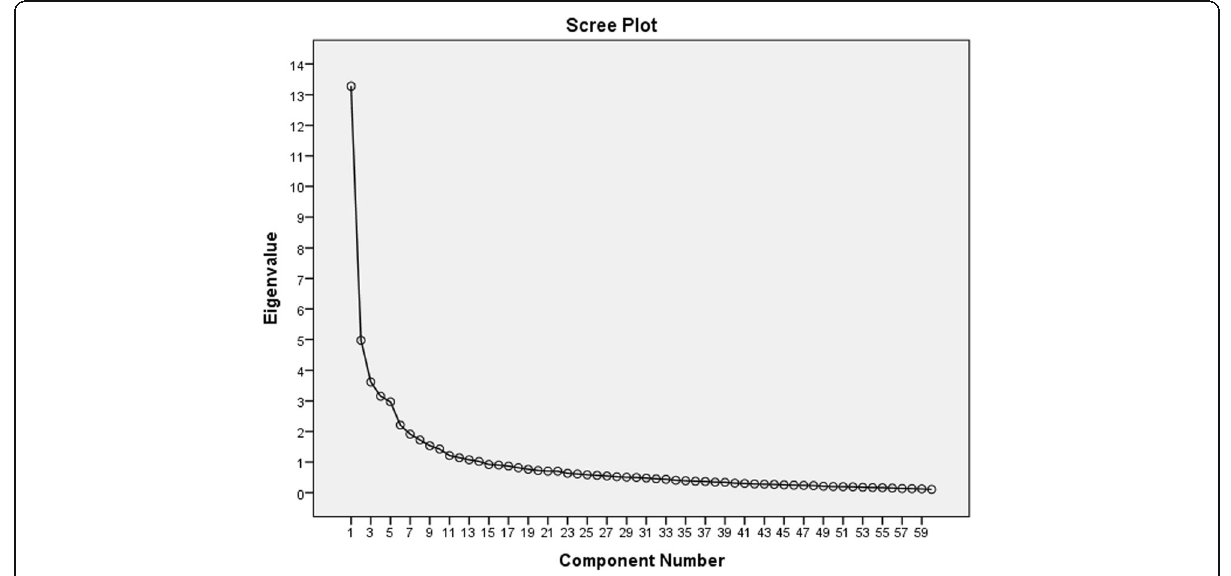
Fig. 2 Scree plot showing elbow at number of components with Eigen values > 1. (elbow at 14